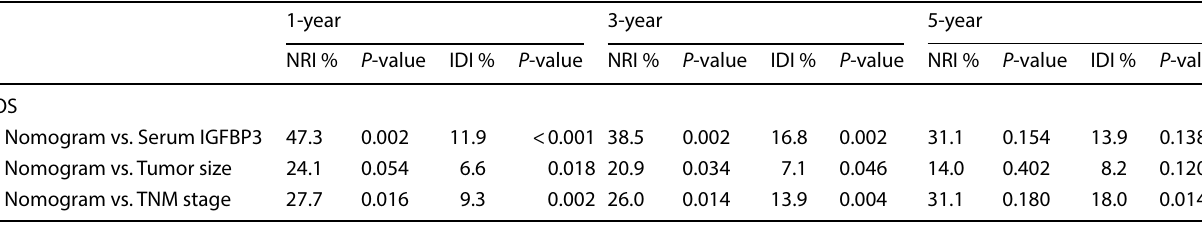
Table 5 Predictive improvement of the nomogram